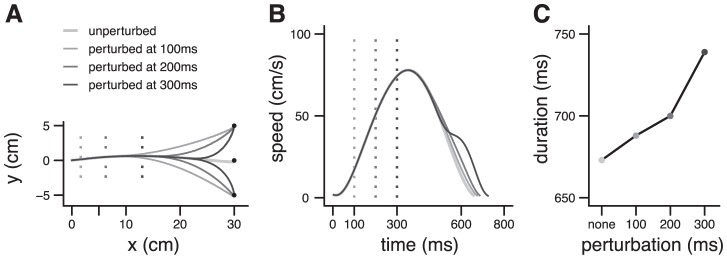
Simulation of Liu and Todorov [29]
.

A. Simulated trajectories for reaching movements toward a target which jumps unexpectedly up or down, 100 ms, 200 ms or 300 ms after movement onset. B. Corresponding velocity profiles. C. Arrival time as a function of the timing of the perturbation. Results obtained with Object IIIa. Initial arm position (deg): (15,120). Same parameters as in Fig. 3.